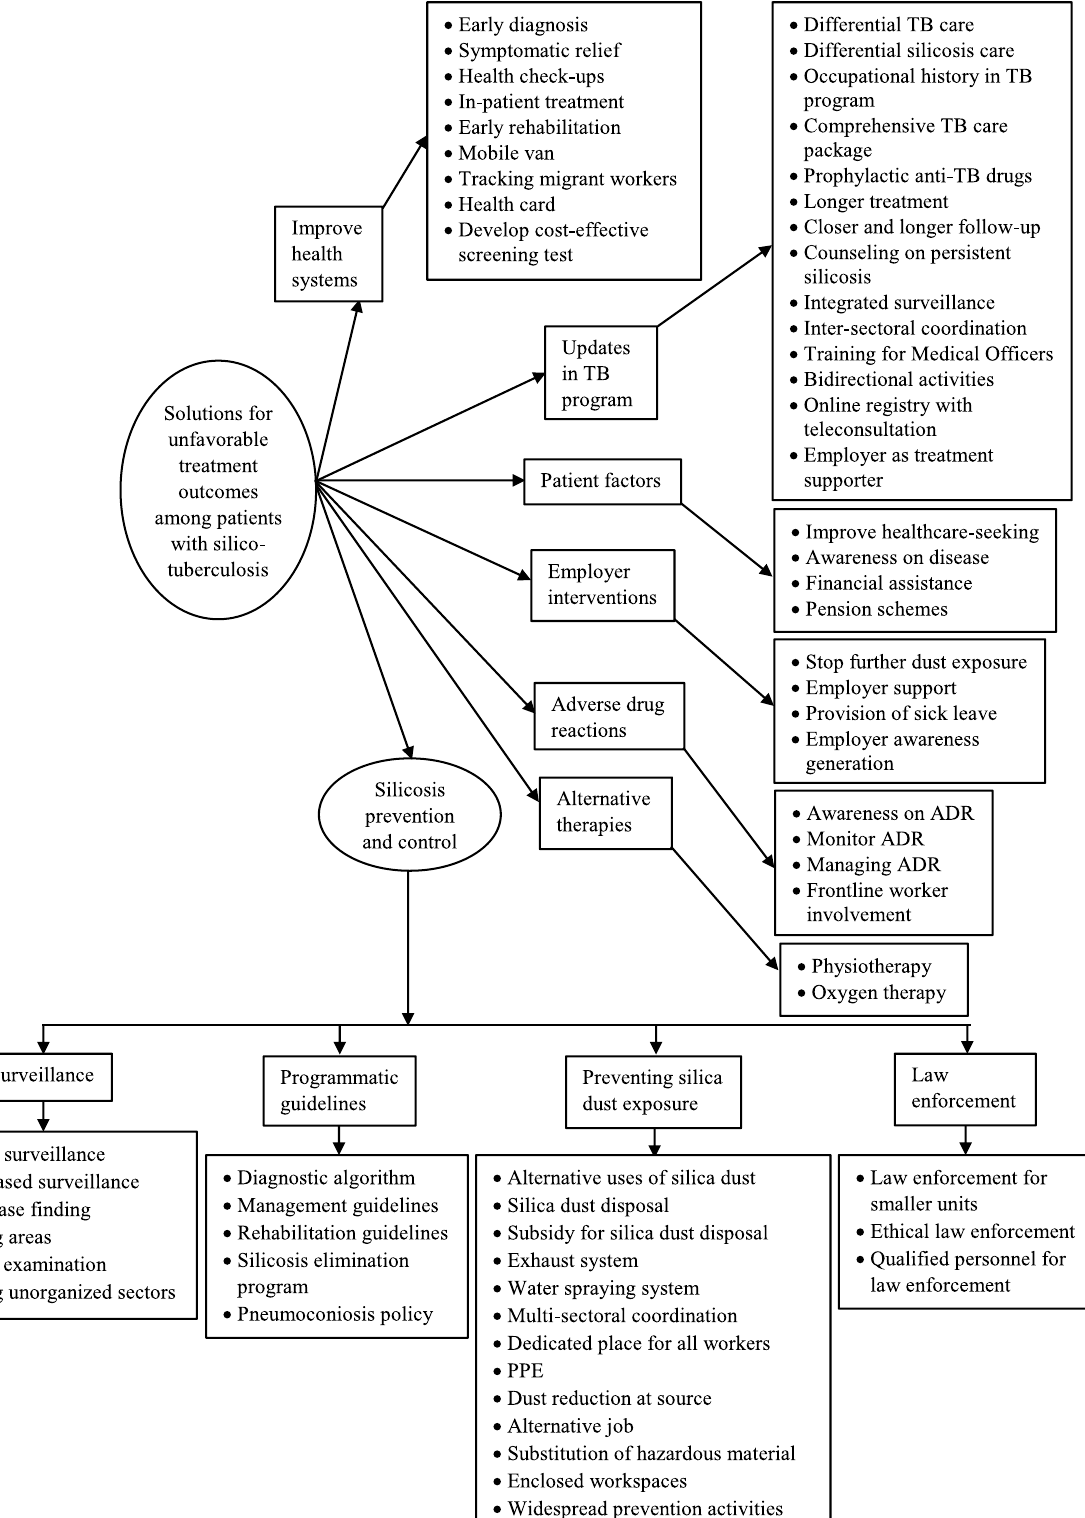
Figure 4. Solutions for unfavorable treatment outcomes among patients with silico-tuberculosis as perceived by experts during April–July